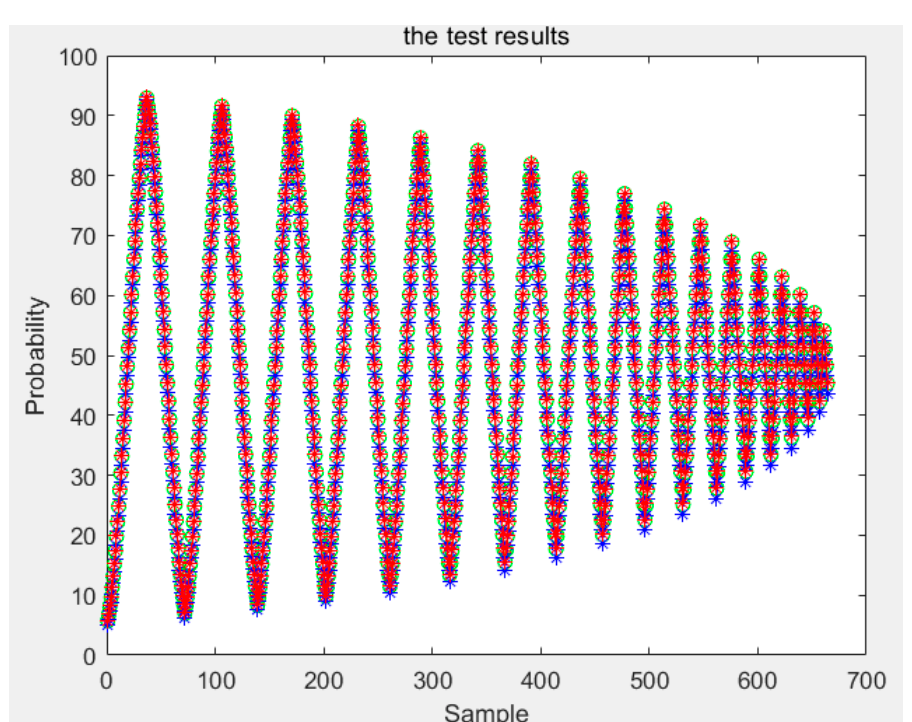
Sensors 2021 , 21 , x FOR PEER REVIEW Figure 13. Errors of the first kind sensor. Figure 13. Errors of the first kind sensor.